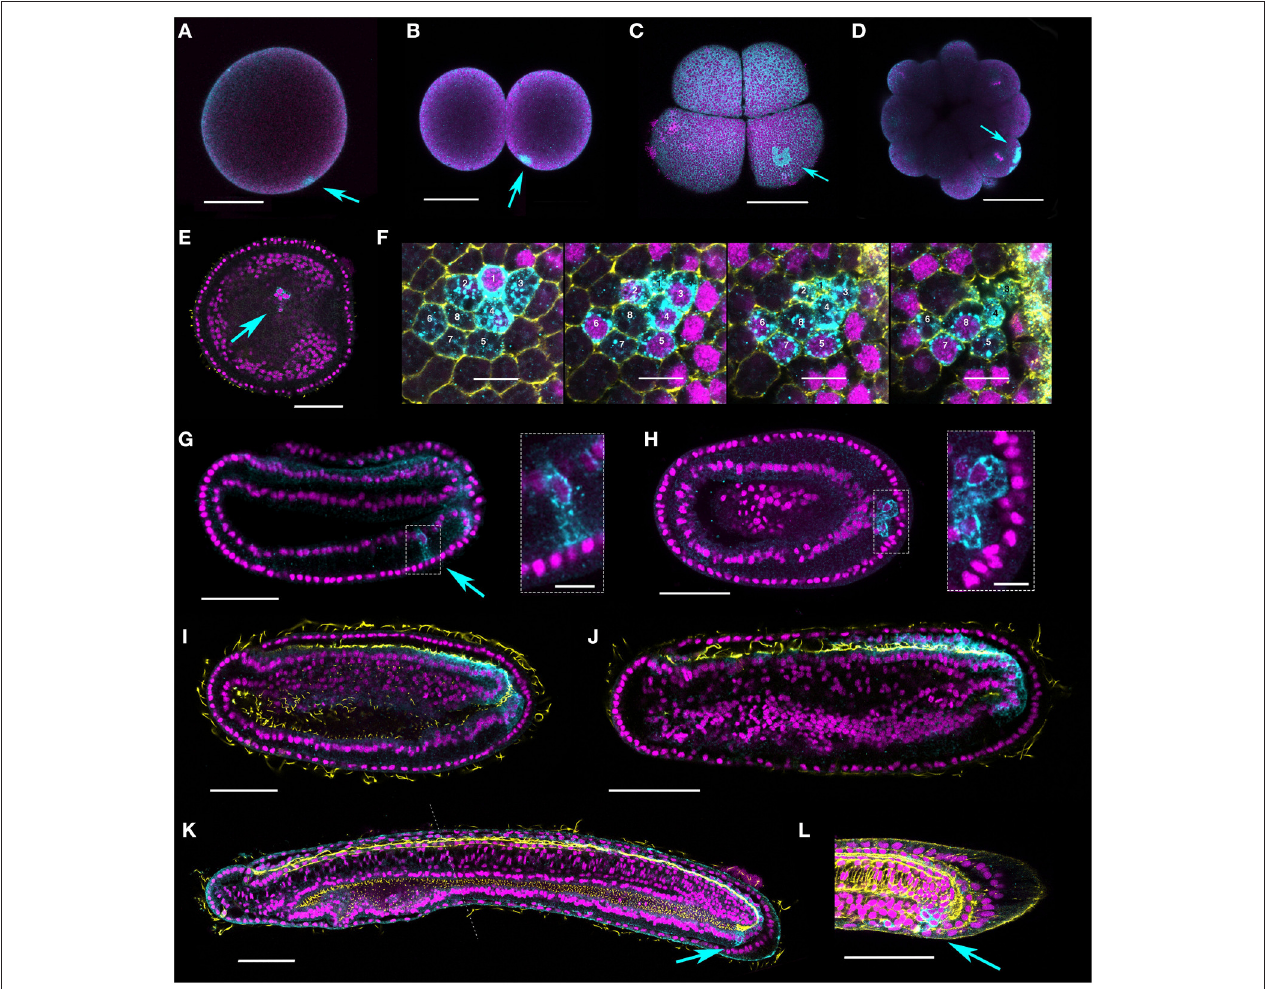
FIGURE 4 | Vasa protein expression during B. lanceolatum embryogenesis. Vasa is expressed in a single point in fertilized eggs (A) , two cell (B) , eight-cell (C), and morula (D) stages (arrows). (E,F) Perinuclear punctae are evident in late gastrula/early neurula (N0–N1) stages in up to eight cells (two different embryos shown, E and F ). (E) shows a cluster of cells of which two clearly express Vasa (arrow). In (F) , a series of z-stacks shows a cluster of eight cells expressing Vasa. Mid-neurula (N2) stage embryos (G,H) are variable, with some individuals showing a cluster of Vasa-positive cells in the ventral endoderm on one side ( G , arrow and boxed inset); in others the putative germ cells are just ventral to and contiguous with the posterior Vasa expression domain ( H , arrow and boxed inset). (I,J) germline expression is difficult to distinguish in late neurula (N3) stage embryos; zygotic expression is most apparent in the posterior neural tube and posteriormost ventral endoderm. (K,L) Clusters of cells are again evident in some pre-mouth stage and late larvae (L1, L2 arrows), and neural expression is much reduced. The dotted line in (K) indicates where two confocal images have been combined. Nuclei stained with Hoescht are false-colored magenta, and Vasa protein is show in cyan. Acetylated tubulin marks axons and cilia in yellow in (E) , (I–K) . Phalloidin stains F-actin yellow in the membranes in (F) and (L) . With the exception of scale bars in (F) and in boxed insets (G,H) , which are 10 microns, all scale bars are 50 microns. Orientations are as follows: (E–L) anterior, left; (E,F,H) , ventral views; (G,I–L) , lateral, dorsal is to the